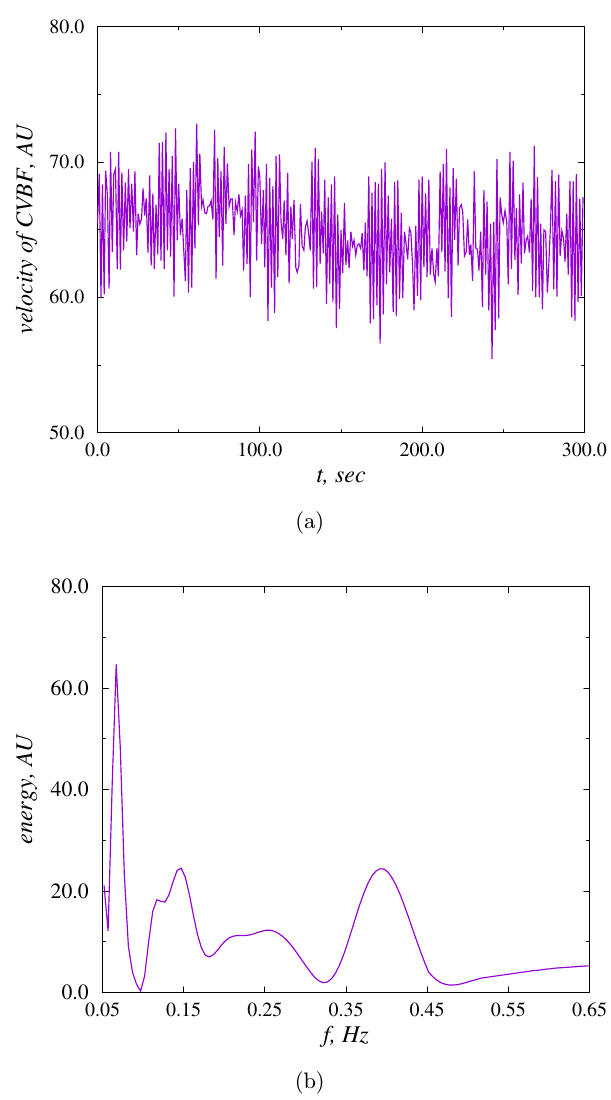
Fig. 3. Analyzed time series (a) and the scalogram